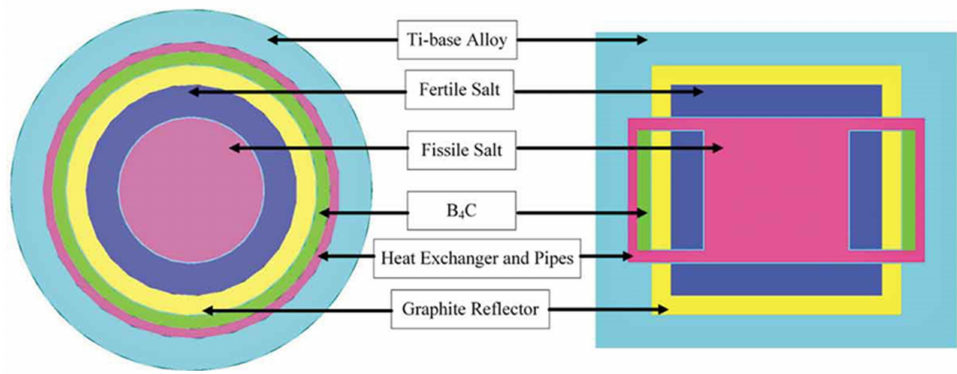
Figure 1. The cross and vertical section of MCFR.